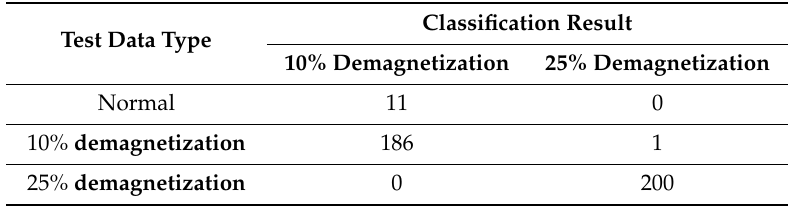
Table 7. Confusion matrix of